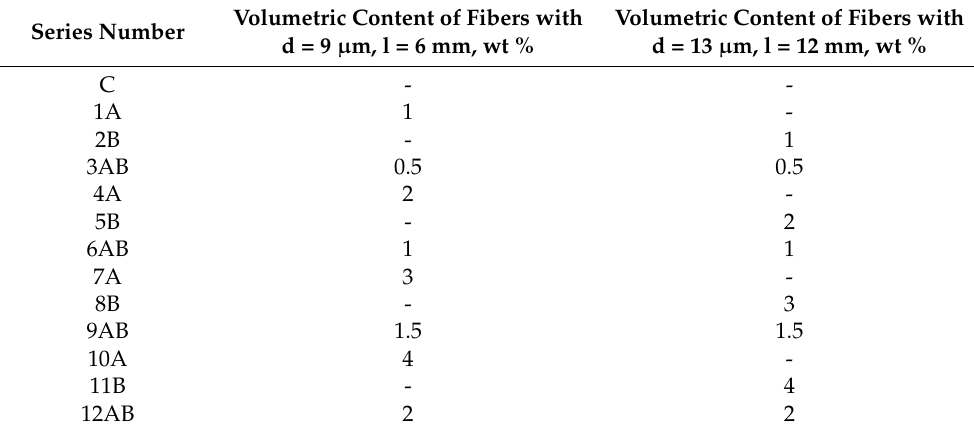
Table 5. Experimental research